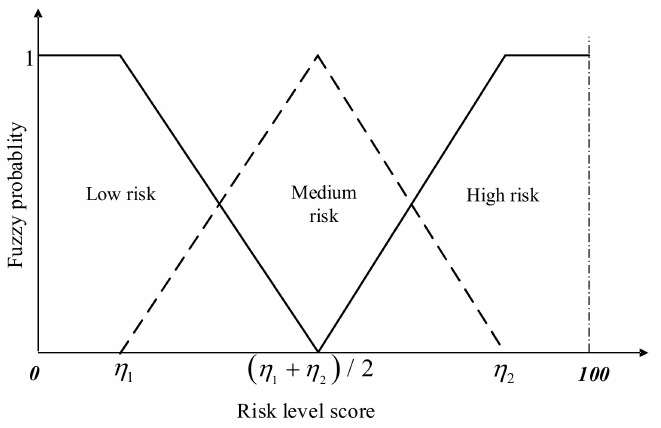
Figure 3. Scoring framework of the risk